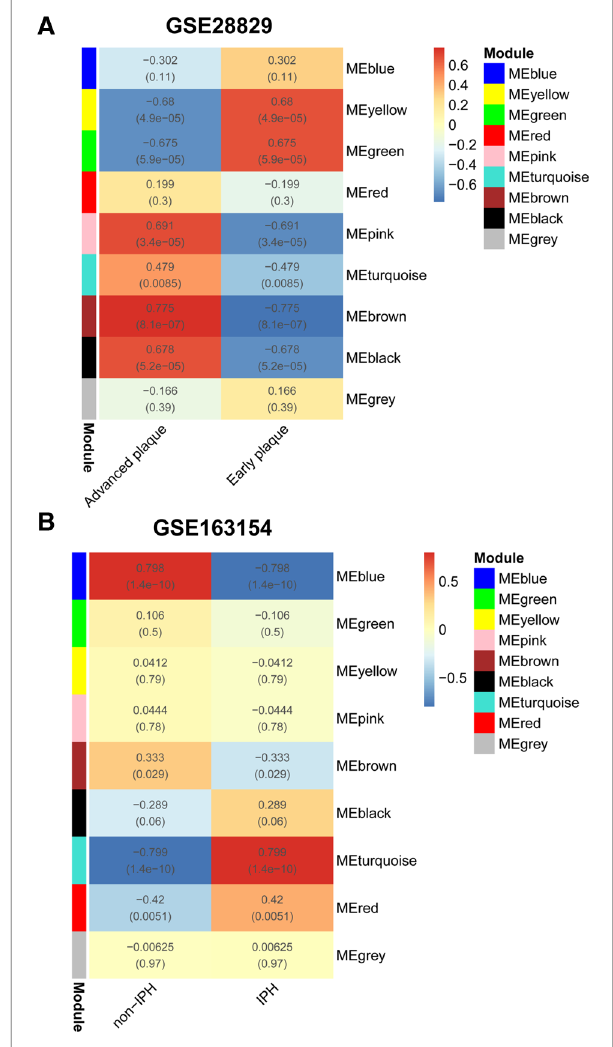
FIGURE 2 WGCNA. ( A ) Relationship between each co-expression gene module and advanced plaques in GSE28829. Each small lattice contains its corresponding correlation value and P -value. ( B ) Relationship between each co-expression gene module and IPH plaques in GSE163154. WGCNA, Weighted Gene Co-Expression Network Analysis; IPH, intraplaque